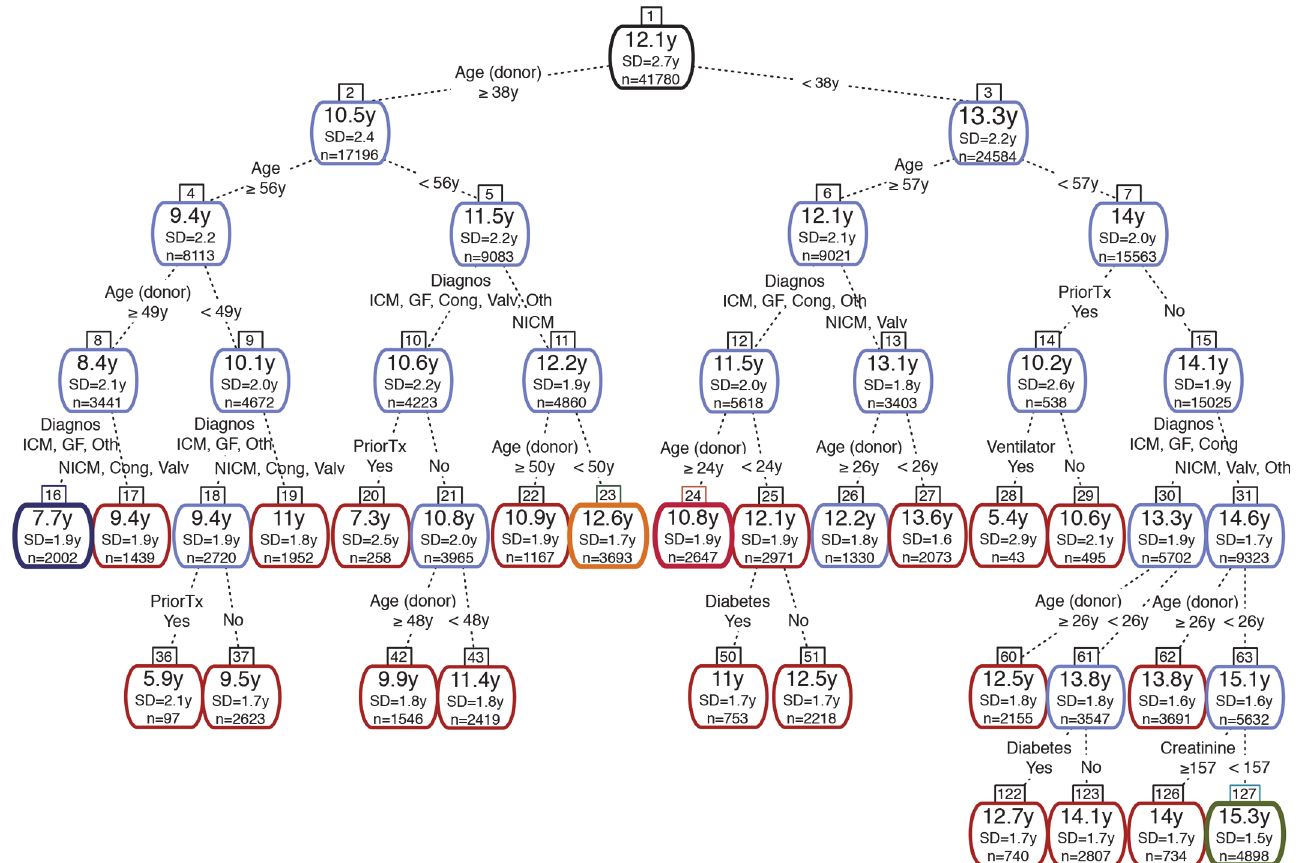
Fig 5. Relative importance for the IHTSA variables. The numbers within the nodes and leaves represent the predicted median survival together with standard deviation (SD) in years (y), and the number of patients the results is based on (n). The decision variable and the criterion are shown on the dotted lines between the nodes. The most important variable is the top node. Light blue coloring of the nodes shows an internal node and red represents a leaf node. Dark blue, dark red, yellow, and green coloring represent the four leaf nodes for which the observed cumulative mortality is plotted against time in Fig. 6. The tree has been pruned to a cost-complexity parameter of 0.0035. Cong, congenital; ICM, ischemic cardiomyopathy; NICM, non-ischemic cardiomyopathy; GF, graft failure; Valv, valvular; Oth,